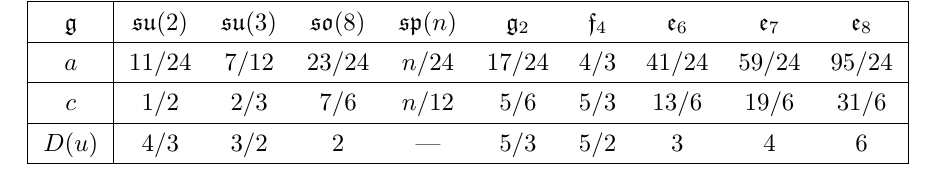
Table 2 . The central charges of SCFTs with flavor symmetry g . This table is taken from [47, 48]. The last row D ( u ) is computed by using 4(2 a − c ) = 2 D ( u ) − 1 for the rank 1 theory [53, 54] (This formula is modified when the gauging of the discrete symmetry is involved [55]). A theory with sp ( n ) flavor symmetry and one-instanton moduli Higgs branch is given by just a free half- hypermultiplet, see also section 3.5. Note that there are two possibilities of the central charges for theories with su (2) = sp (1) flavor symmetry. One is the interacting SCFT ( su (2) in table), another is the free SCFT ( sp (1) in